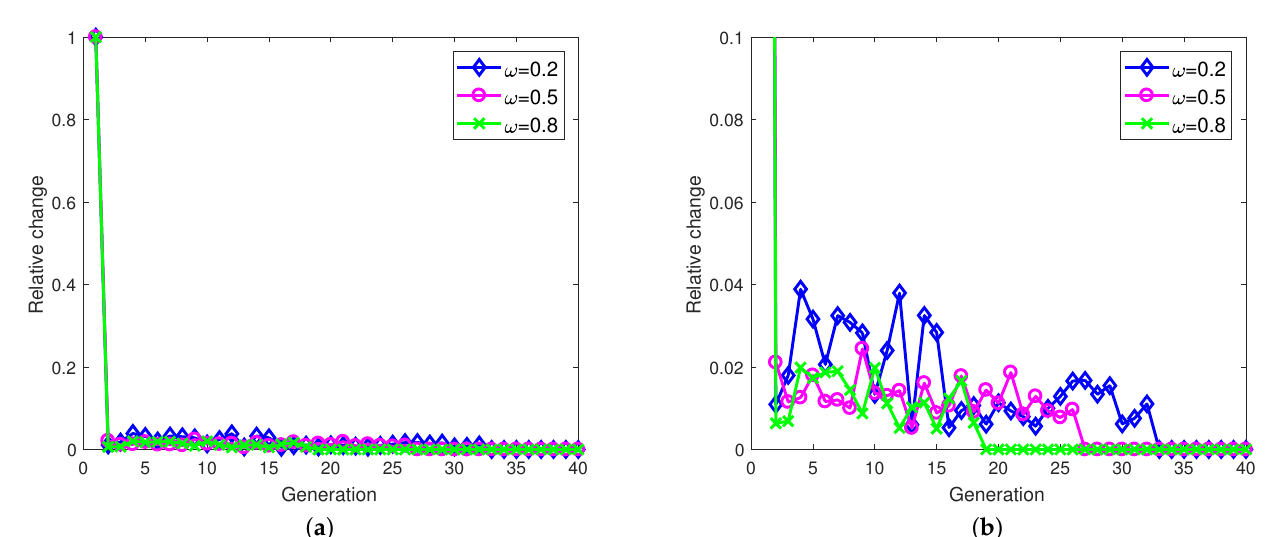
Figure 9. The convergence of the proposed TT-ID algorithm, where η = 75%. ( a ) Completed; ( b ) Part enlarged.